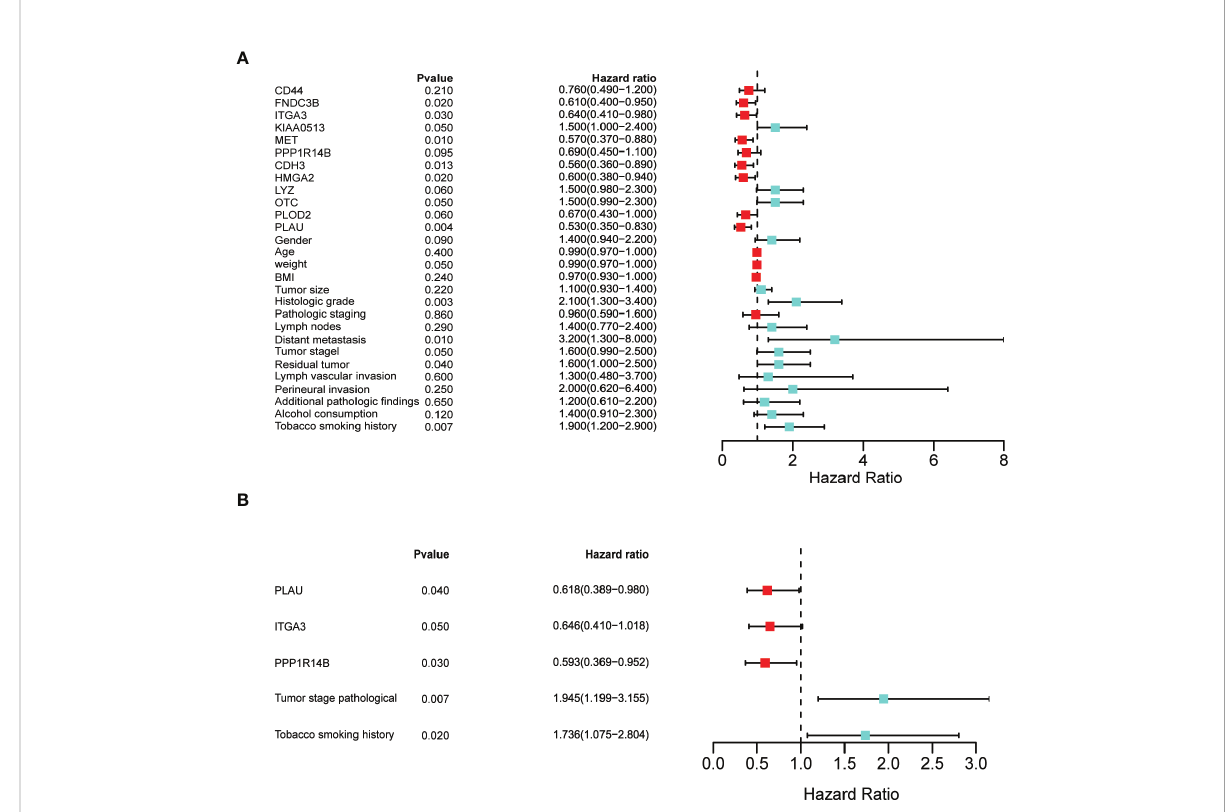
FIGURE 12 Identi fi cation of prognostic factors by univariate and multivariate analyses (A) Univariate Cox regression analysis of the following as individual prognostic factors: eight proteins (PLAU, MET, ITGA3, CDH3, FNDC3B, HMGA2, KIAA0513, OTC), weight, histological grade, distant metastasis, tumour stage, residual tumour, and tobacco smoking history. (B) Multivariate analysis identi fi ed three proteins (PLAU, ITGA3, and PPP1R14B), tumour stage and tobacco smoking history as signi fi cant prognostic